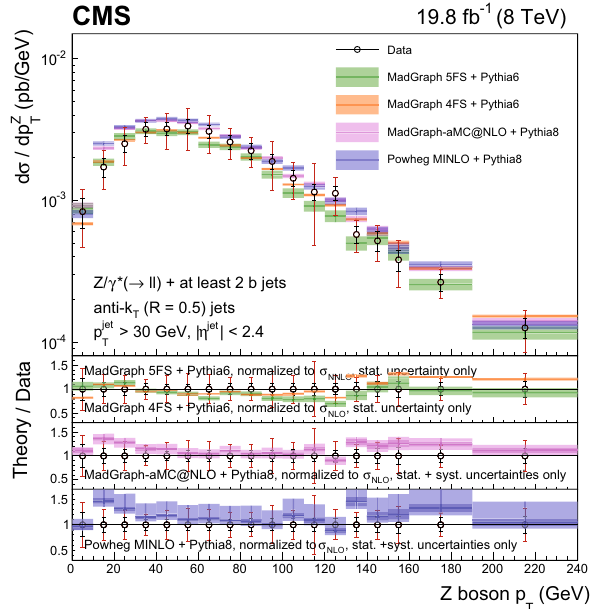
Fig. 12 Differential fiducial cross section for Z(2b) production as a function of the invariant mass of the b jet pair, M bb , compared with the MadGraph 5FS, MadGraph 4FS, MadGraph5 _a MC@NLO , and powheg minlo theoretical predictions ( shaded bands ), normalized to the theoretical cross sections described in the text. For each data point the statistical and the total (sum in quadrature of statistical and system- atic) uncertainties are represented by the double error bar . The width of the shaded bands represents the uncertainty in the theoretical predic- tions, and, for NLO calculations, theoretical systematic uncertainties are added in the ratio plots with the inner darker area representing the statistical component